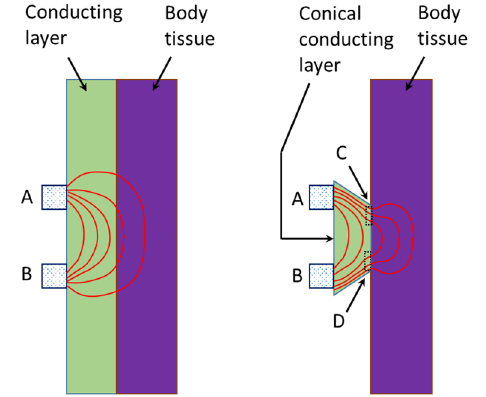
Fig. 2: Schematic representation of the effect of an interposed conducting layer through imaginary current line patterns: a) for a 2D infinite layer, b) for a conical finite layer, giving rise to virtual electrodes with reduced